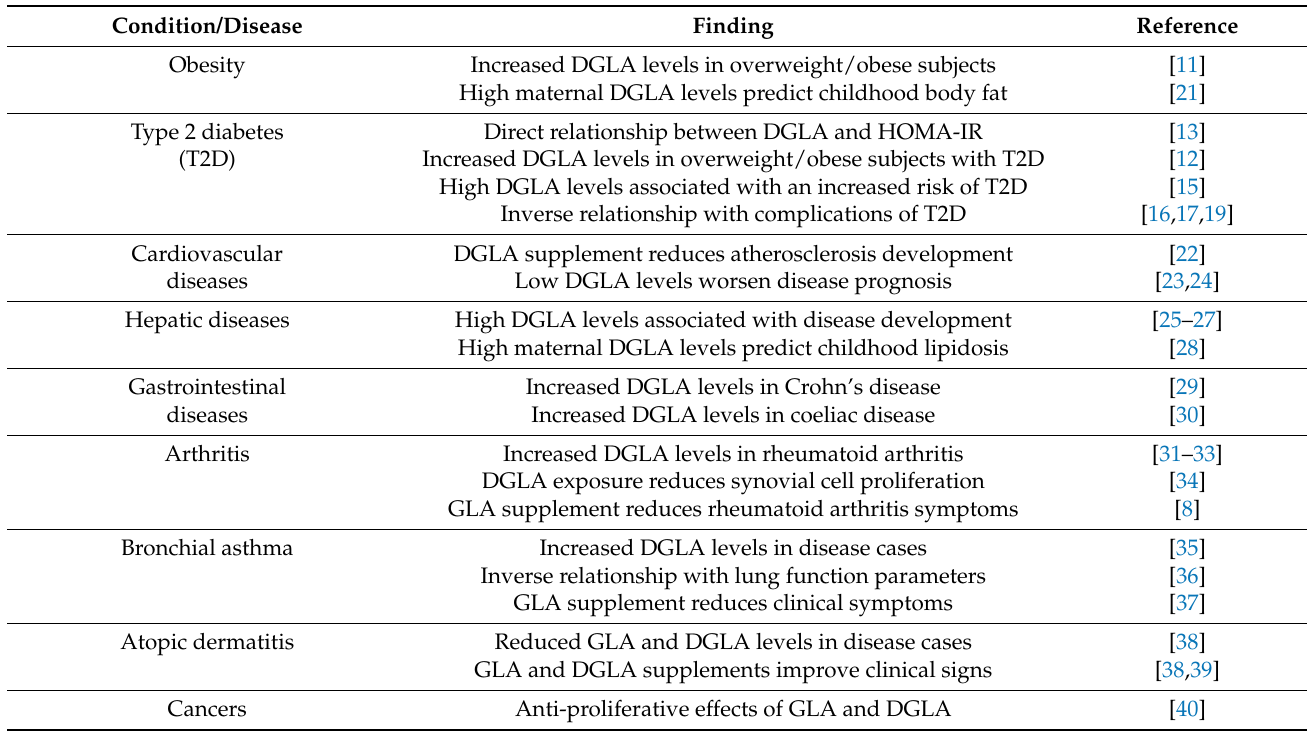
Table 1. Selected data regarding dihomo- γ -linolenic acid (DGLA) or, in some cases, γ -linolenic acid (GLA) and their potential associations to inflammatory disease risk or